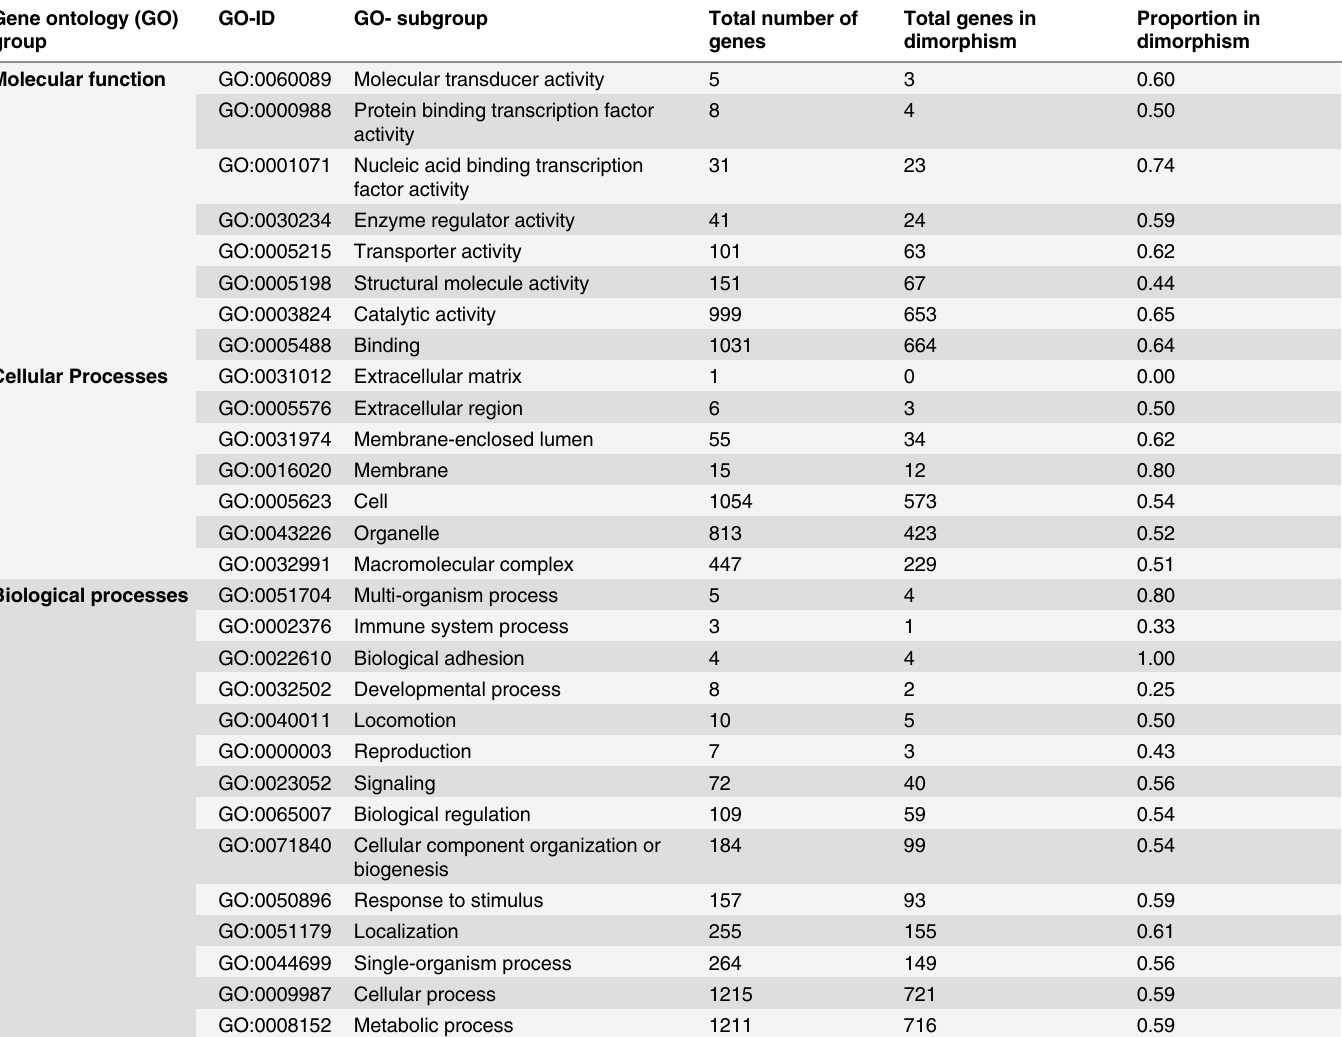
Table 3. Summary of P . knowlesi gene ontology (GO) analysis and the proportion of genes in each group with dimorphic SNP's. Gene ontology (GO)